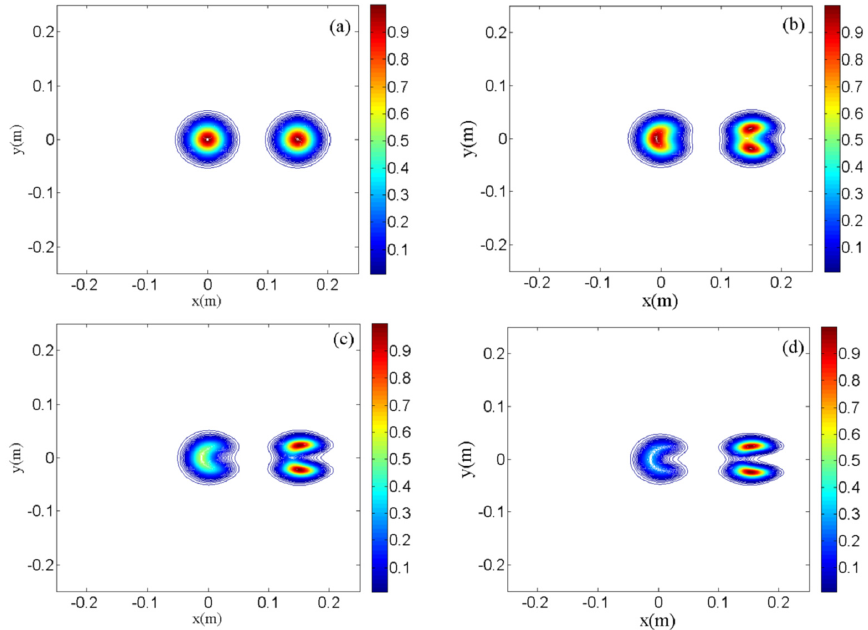
by the middle and left beams. Compared with the middle beam, a stronger thermal lens effect will split the right beam into two parts rapidly.